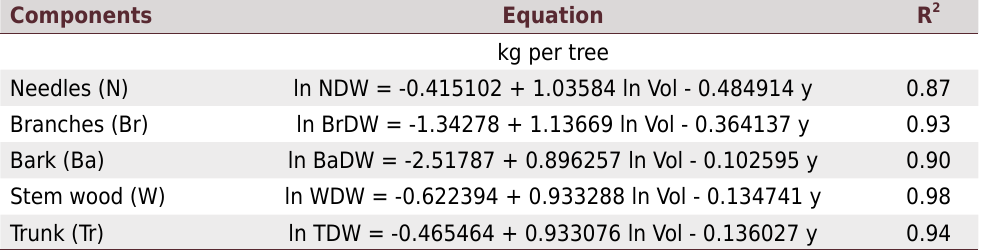
Table 4. Regression equations to estimate the dry weight of needles, branches, bark, and stem wood in P. taeda stands